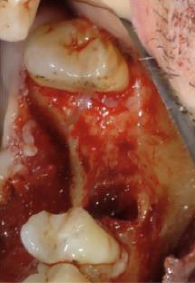
Figure 3. Detail of the design of the palatal flap.